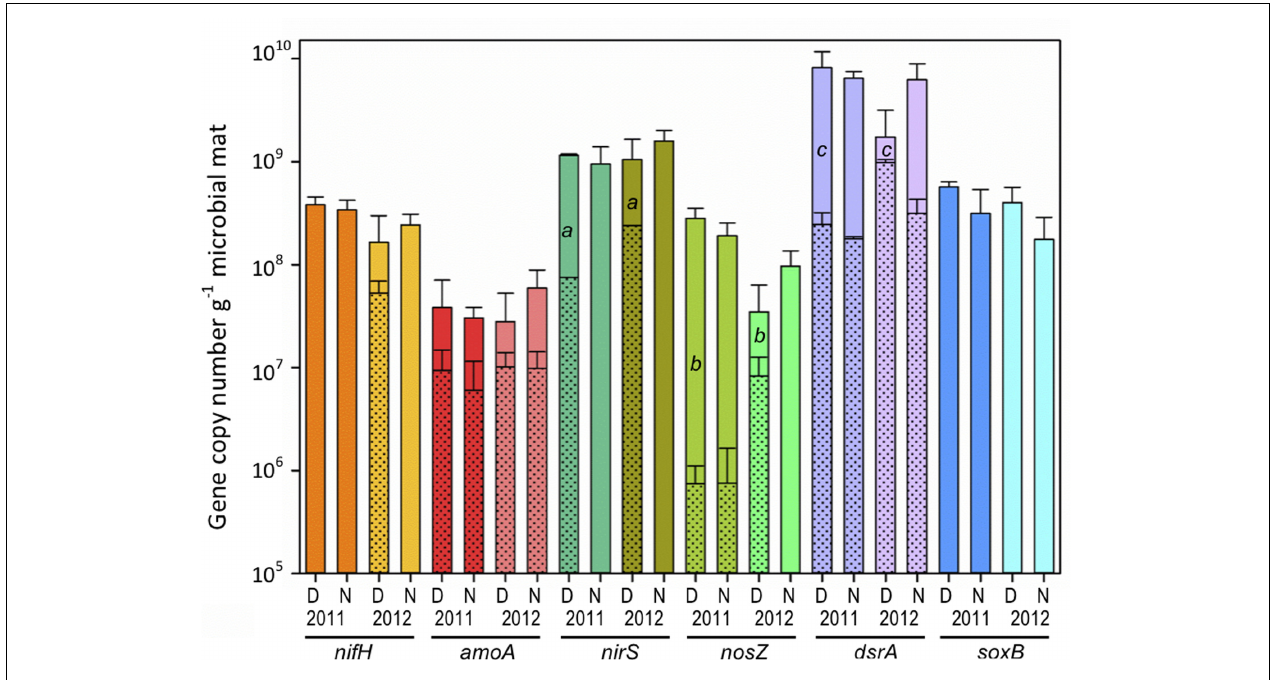
FIGURE 6 | Microbial mat community potential for biogeochemical cycling as determined by qPCR amplification of genes (DNA) and transcripts (cDNA) involved in nitrogen and sulfur cycling for day (D) and night (N) samples during 2011 (11) and 2012 (12) ( n = 6). Nitrogen cycling genes/transcripts analyzed: nitrogen fixation ( nif H), archaeal nitrification ( amo A), and denitrification ( nos Z, and nir S). Sulfur cycling genes/transcripts analyzed: sulfate reduction ( dsr A) and sulfide oxidation ( sox B). Shaded areas within solid bars represent transcript abundance (no shade indicates that transcripts were not detected). Different lower case letters indicate significantly different cDNA/DNA ratios across years (independent t -test, p <